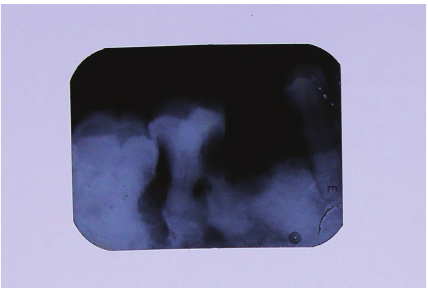
Figure 4: Specimen radiograph confirming the presence of a hard calcified radiopaque material on the root surfaces. A clear demarcation is visible between the primary root surface and the secondary